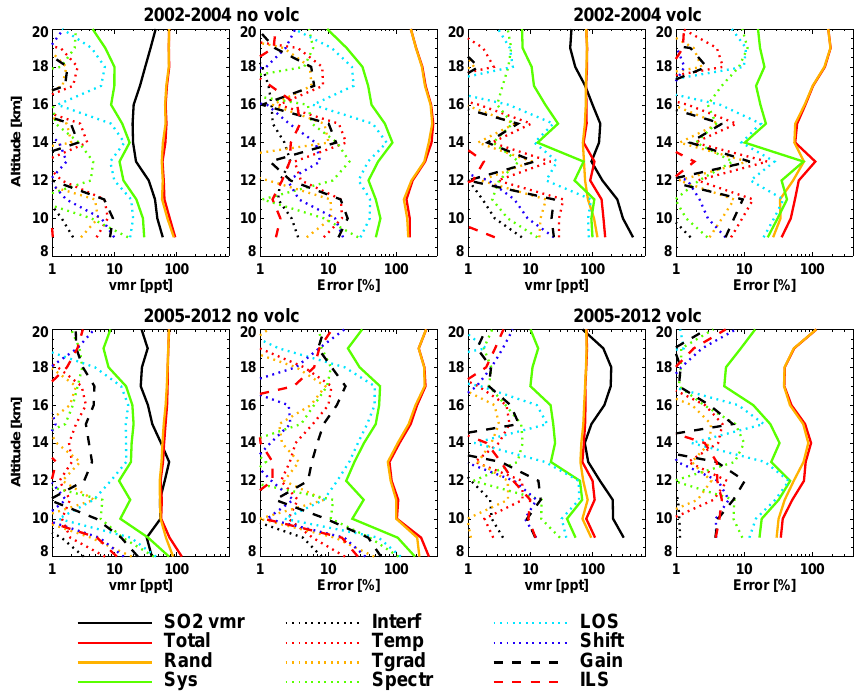
Figure 1. Four pairs of plots showing single profiles error estimates for MIPAS SO 2 . Within each pair the left plot represents the absolute and the right plot the relative errors. Left pairs: no clear volcanic enhancement; right pairs: volcanically enhanced profiles; top: MIPAS period P1; bottom: MIPAS period P2. Meaning of abbreviations in the legend: “Total” is the combined random and systematic error; “Rand” is the random error; “Sys” is the systematic error; “Interf” is the error due to uncertainty of interfering species; “Temp” is the temperature error; “Tgrad” is the error due to neglect of a horizontal temperature gradient; “Spectr” is the spectroscopic data error; “LOS” is the error due to line-of-sight pointing uncertainty; “Shift” is the spectral shift error, “Gain” is the radiometric gain calibration uncertainty; “ILS” is the uncertainty of instrumental line